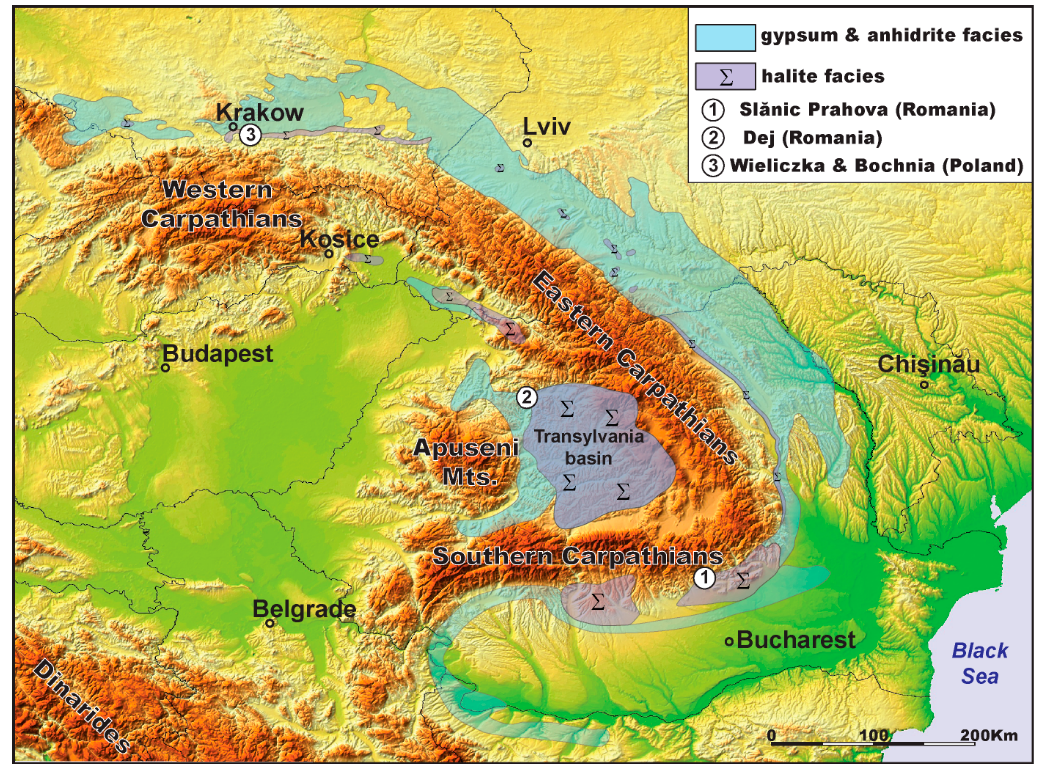
Figure 5. Areal distribution of Late Badenian evaporitic deposits in the Carpathian area.